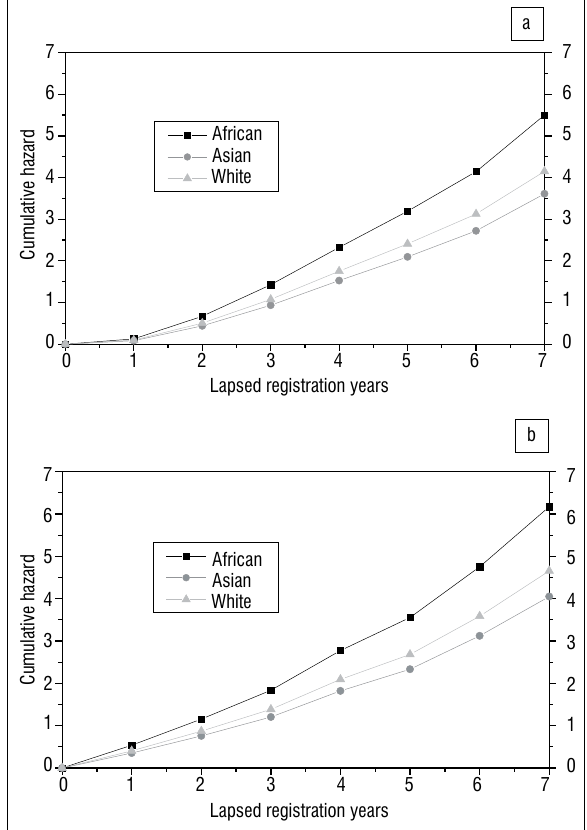
Figure 5: Cumulative hazard functions by race for master’s students who (a) graduated or (b) dropped out of study at the University of KwaZulu-Natal.